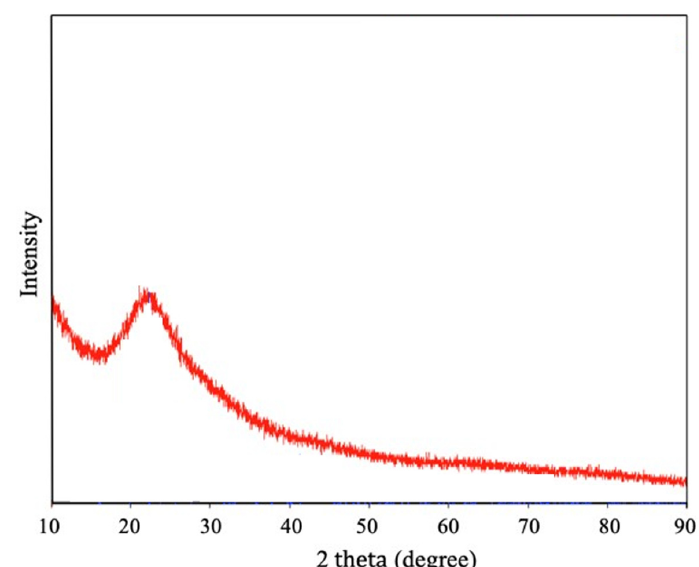
Figure 3. X-ray diffractograms of silica xerogel from corn husk.